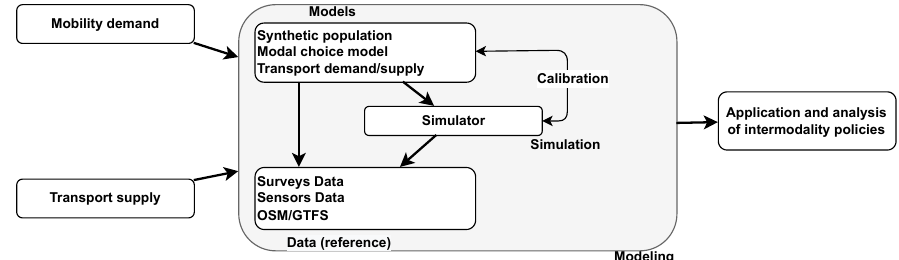
Figure 1. Diagram of the pipeline of an agent-based inter-modality simulation.